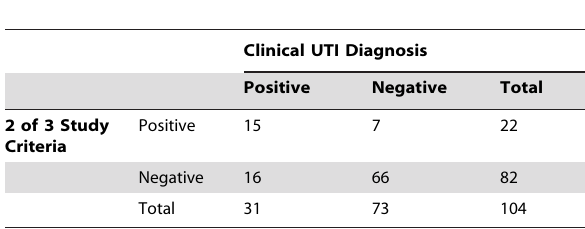
Table 1. Prevalence of UTI in women 18–45 years of age in Veraguas, Panama.